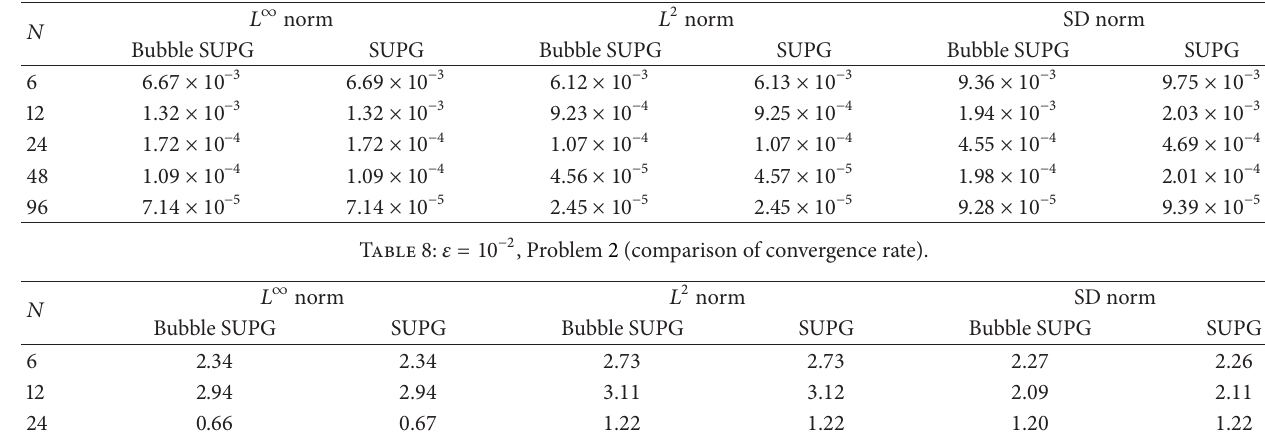
Table 7: 𝜀 = 10 −2 , Problem 2 (comparison of error).